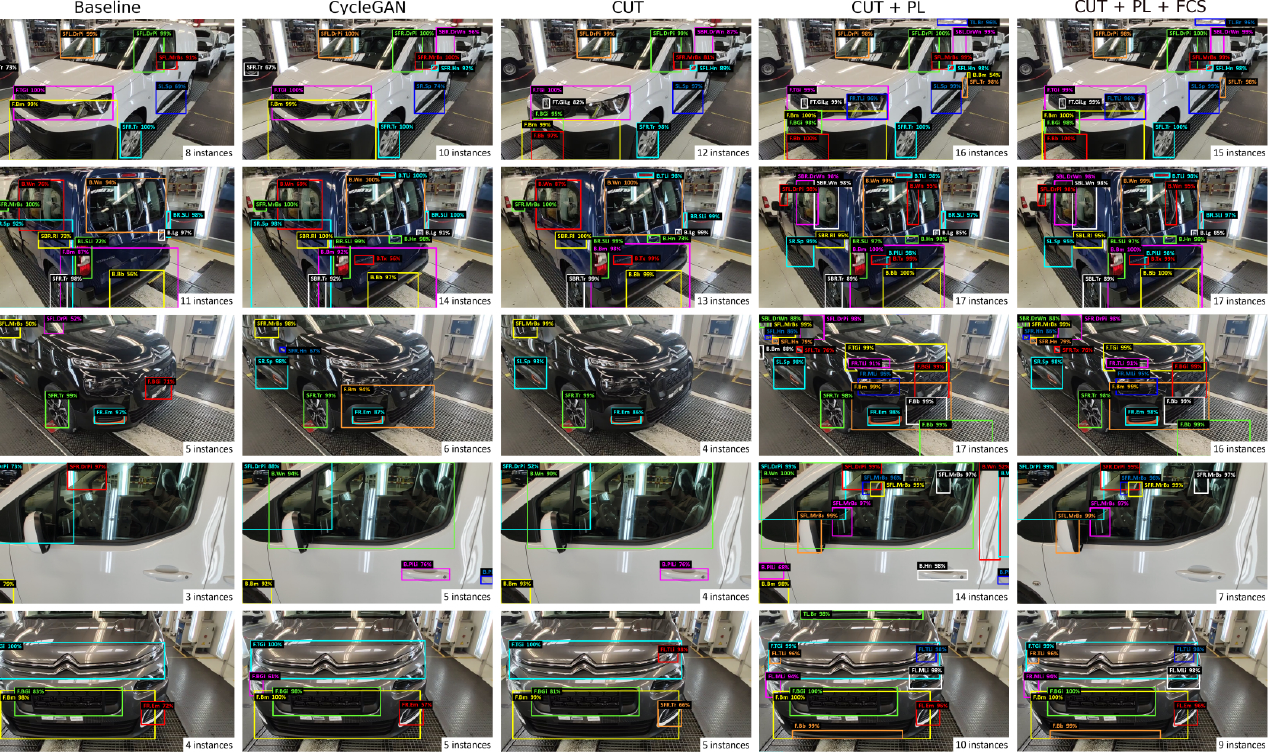
Figure 7. Examples of detection results on real test images with different improvements upon the Baseline, including fine-tuning with CycleGAN and CUT converted images and fine-tuning the latter model with pseudo labeling (PL) of real images. The last column represents the results of the simulation of a fixed camera setup